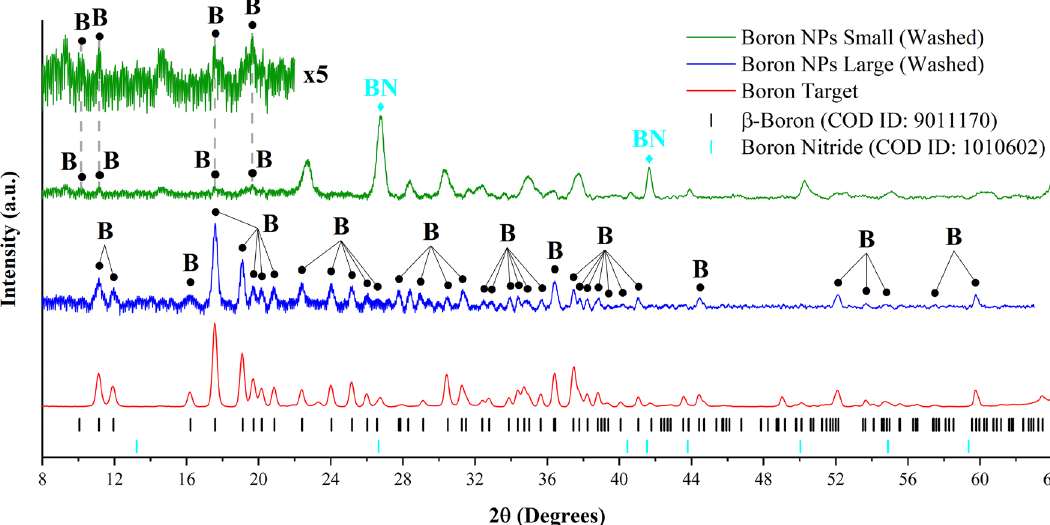
Figure 3. X-ray diffraction ( XRD) measurements of NPs produced by laser ablation in deionized water after centrifugation and purification steps. XRD spectra for large and small size populations of NPs are shown by blue and green lines, respectively. The inset shows a magnified XRD spectrum for most intense lines of B. Lower lines show XRD patterns for crystalline boron (black) and boron nitride